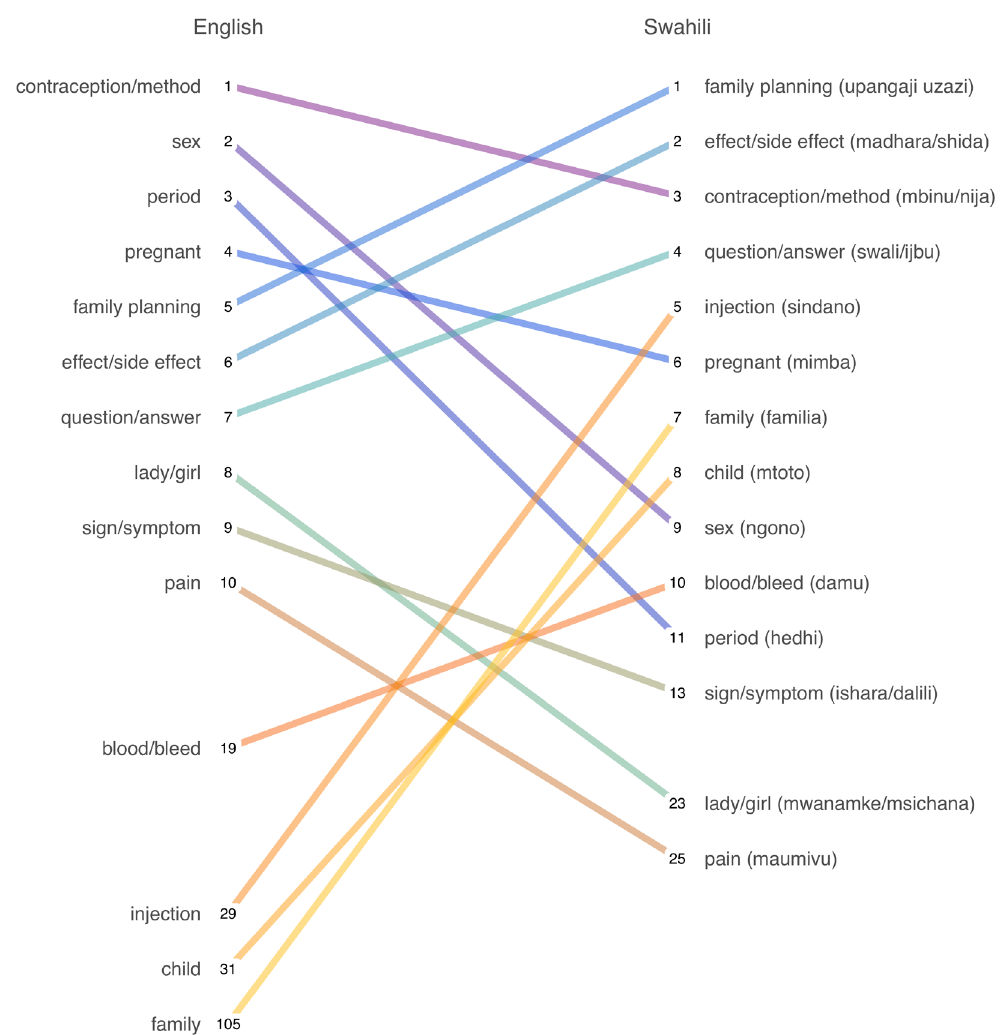
Figure 4. Rank order of the most common words used in incoming messages by language. This is a forced-rank chart because two words could have the same frequency of usage, but no ties are awarded.